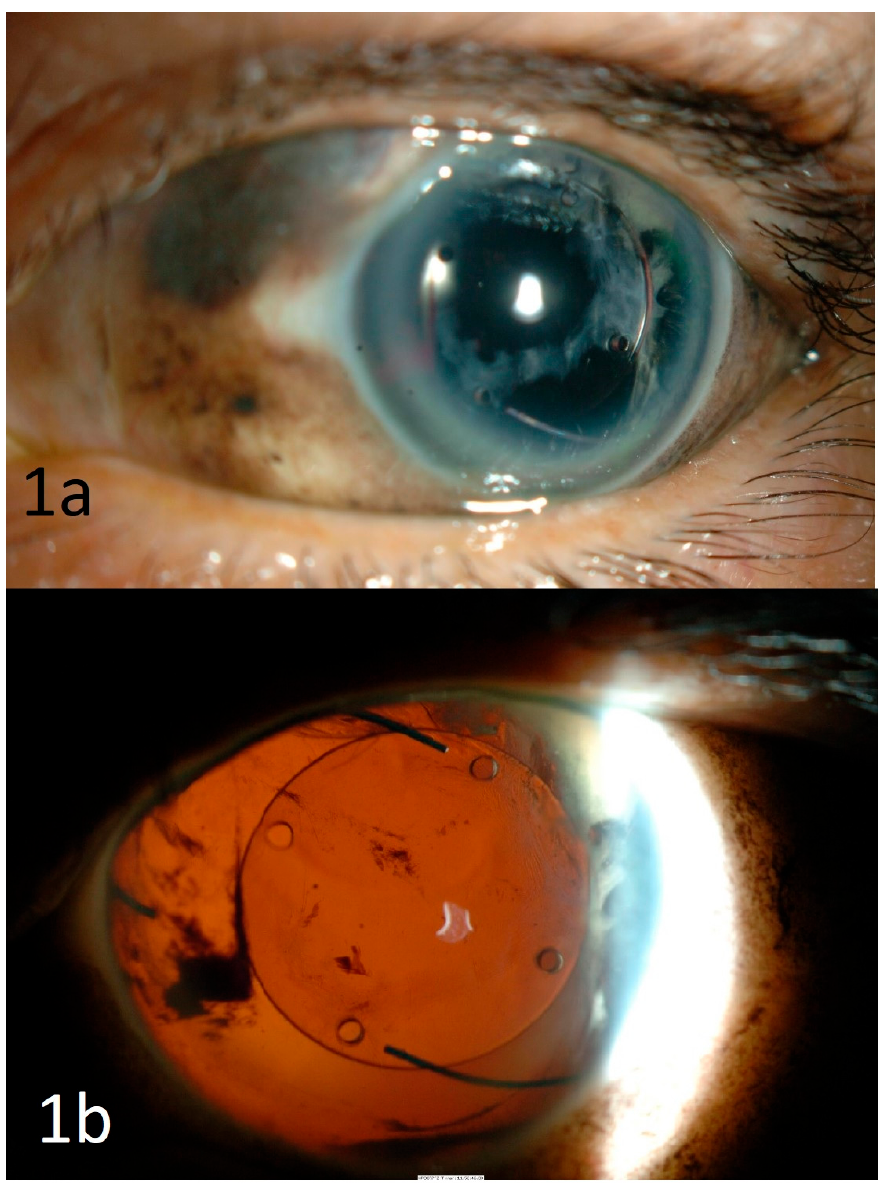
Figure 1. Slit-lamp examination photographs. ( a ) Slit-lamp examination photograph of the left (injured) eye showing loss of iris and iris pigments found under the subconjunctival space superonasally, with a well-centred intraocular lens in the posterior capsular bag with no subluxation. ( b ) Slit-lamp examination photograph of the left (injured) eye a month after the injury showing complete loss of iris.